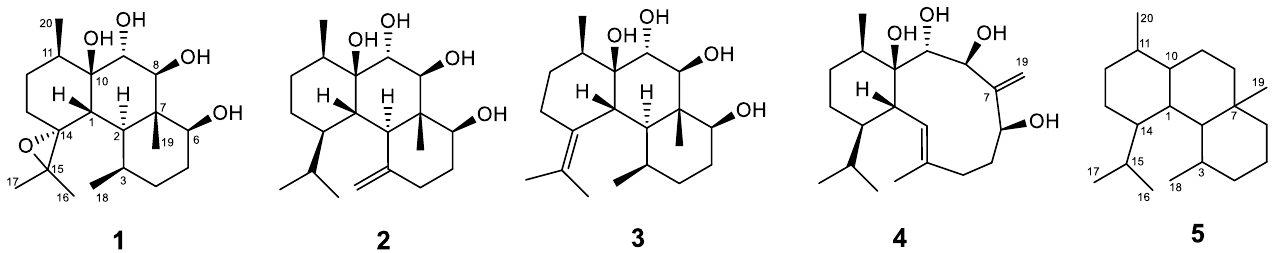
Figure 1. Structures of new diterpenoids isolated from B. violaceum ( 1 – 4 ) and the klysimplexane skeleton ( 5 ).